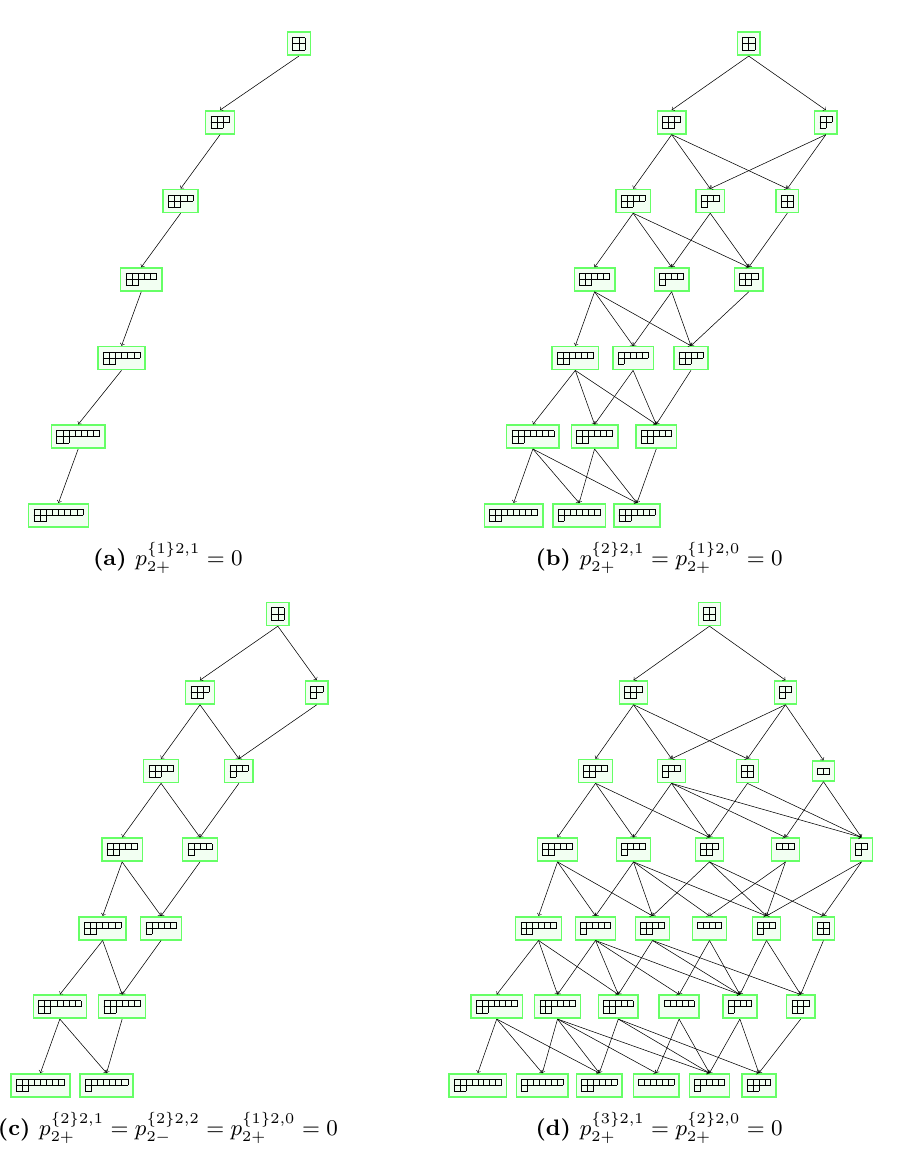
Figure 7. Various on-shell